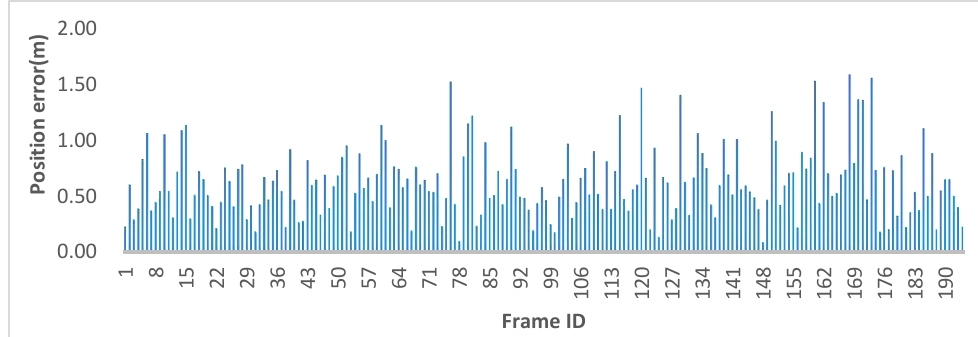
Figure 17. Position error of deep learning position network (PoseNet) in closed round hall. Appl. Sci. 2019 , 9 , x FOR PEER REVIEW